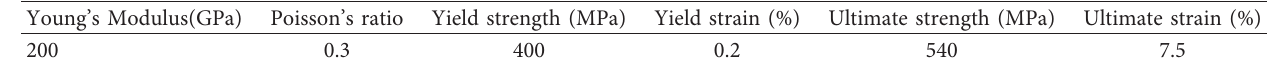
Table 2: Physical and mechanical parameters of the rebars.